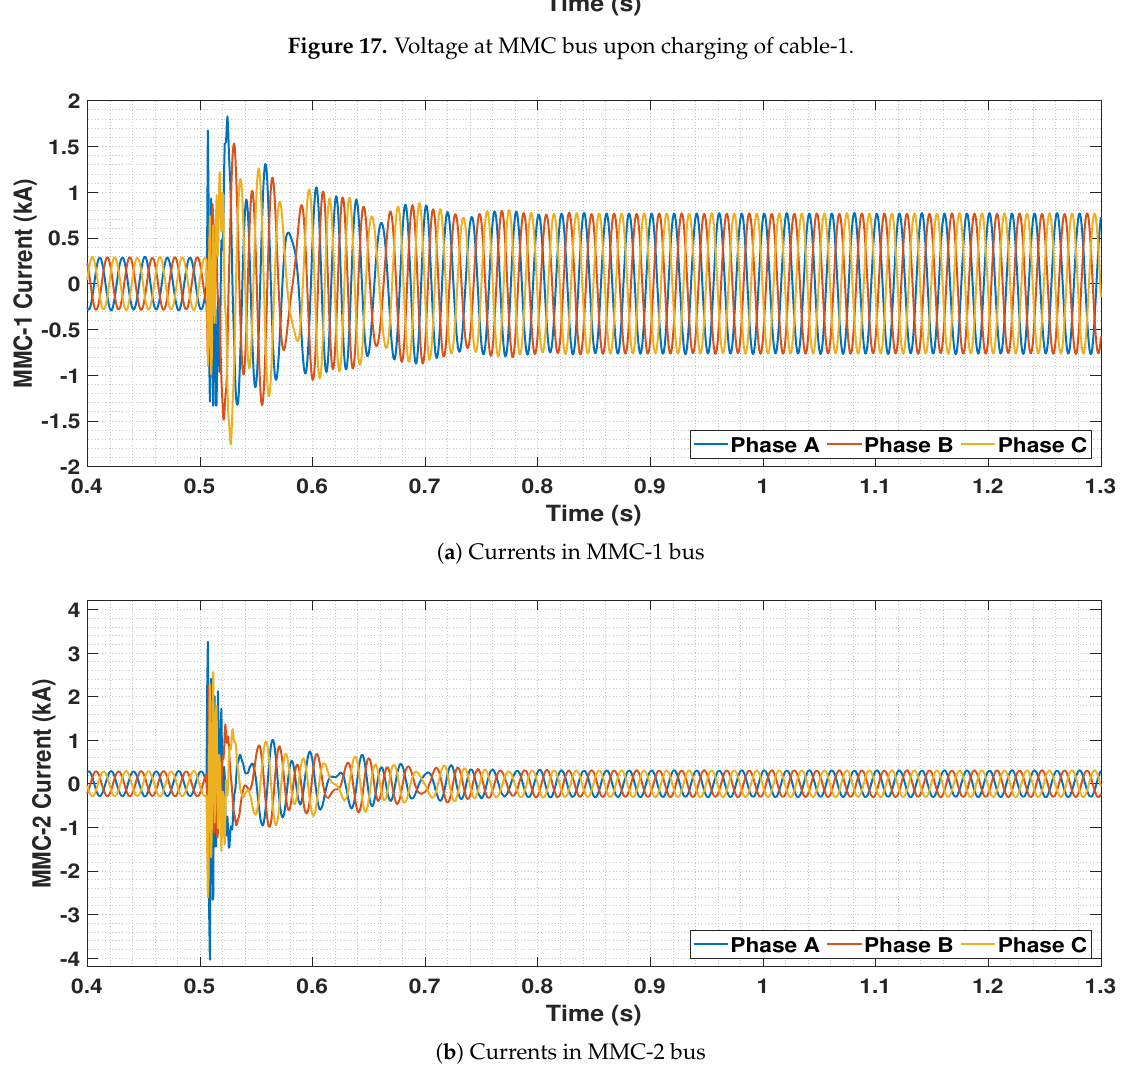
Figure 18. Currents in ( a ) MMC-1 bus ( b ) MMC-2 bus upon CB-1a closing operation for charging of